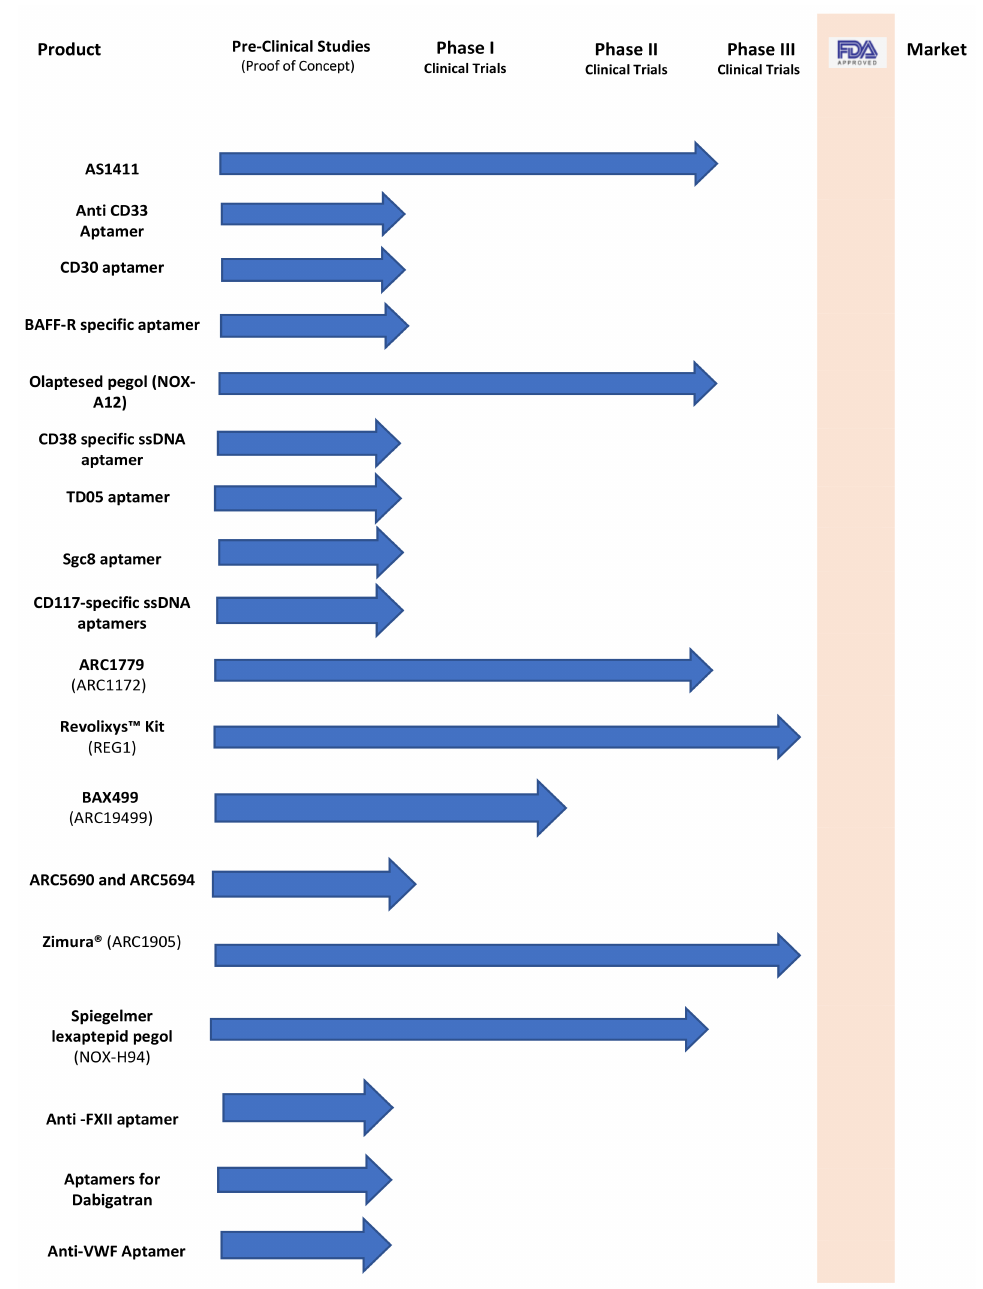
Figure 3. Aptamers in the therapeutics and diagnostics pipeline for blood